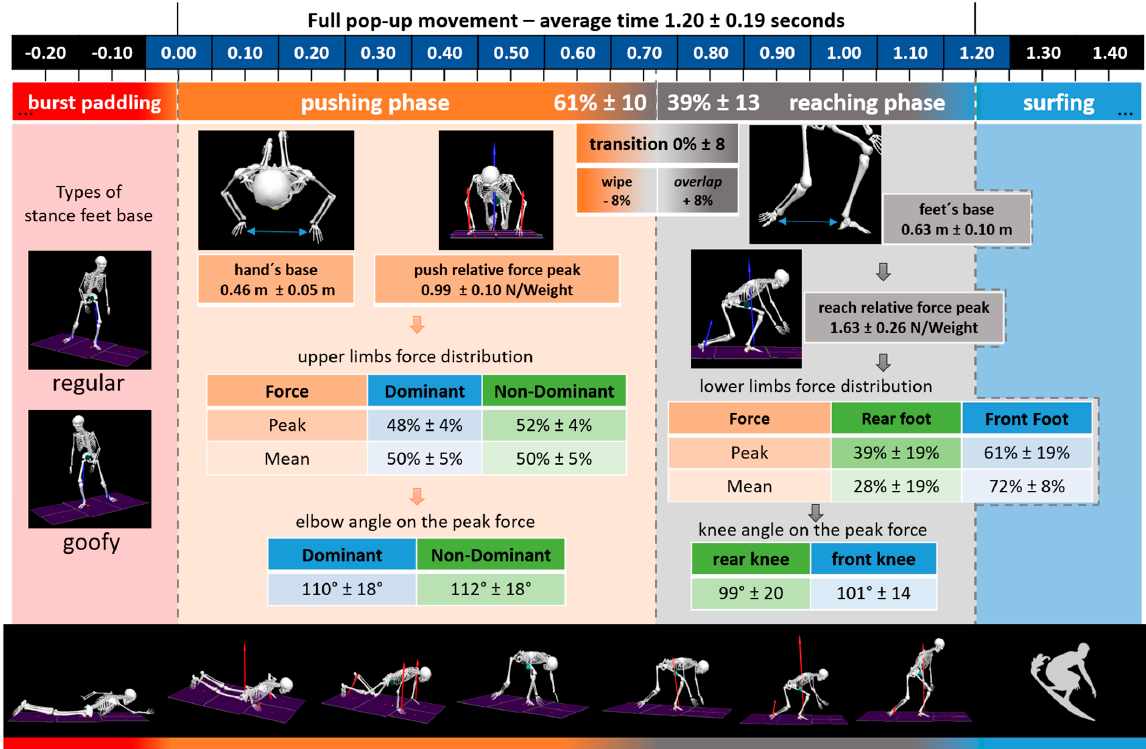
Figure 4. Infographic of pop-up movement results .